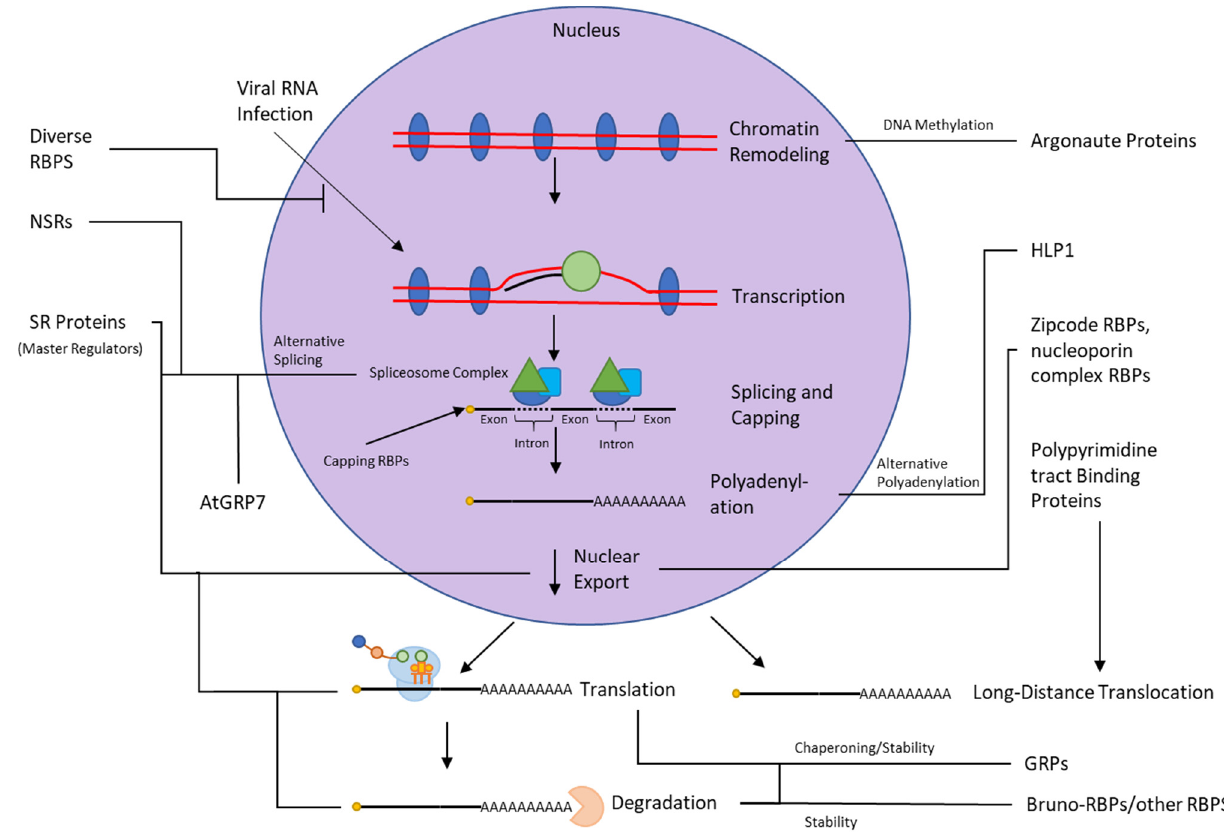
Figure 4. Summary of Known RNA-Protein Interactions in Plants. RNA-Binding Proteins play significant roles in carrying out and regulating every step and stage of the existence of RNAs. This diagram illustrates currently known RBPs and their RNA-binding roles, highlighting their ubiquity. Most of these RBP classes are capable of both positive and negative regulation, and as such lines indicating their activity have been left without arrows or bars.